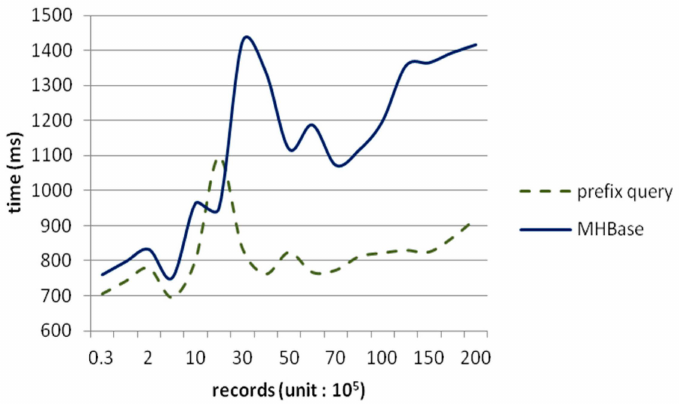
Figure 9. Time of indices query and prefix